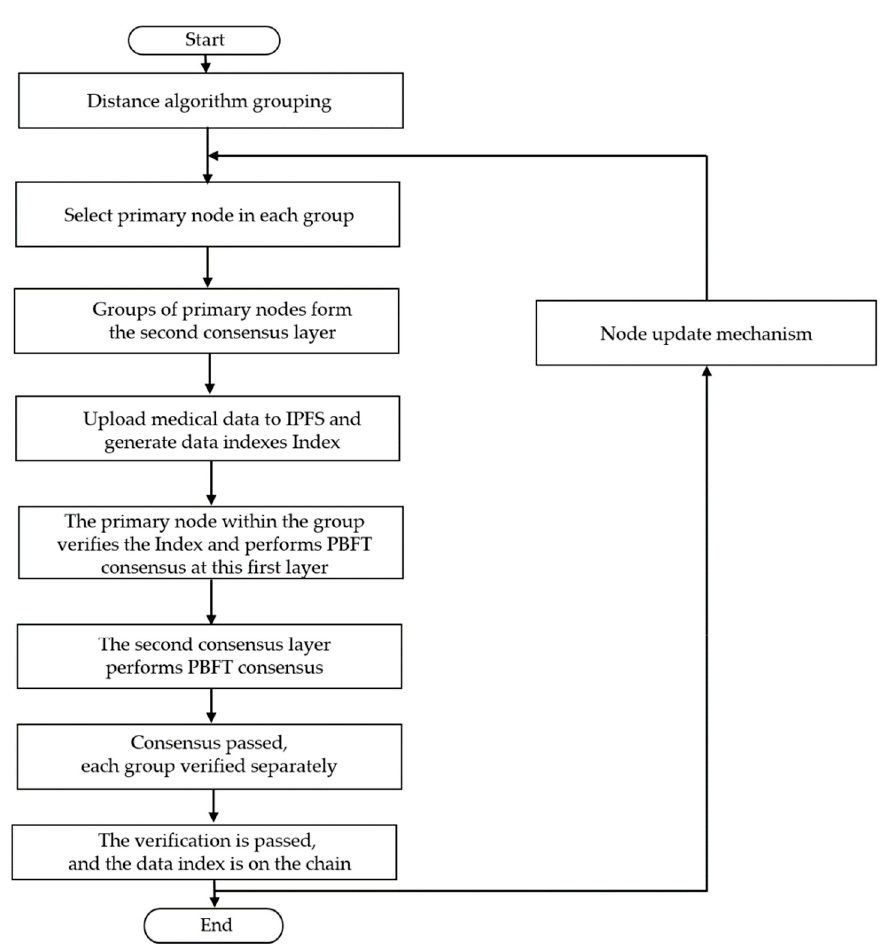
Figure 2. General flow chart of the model.